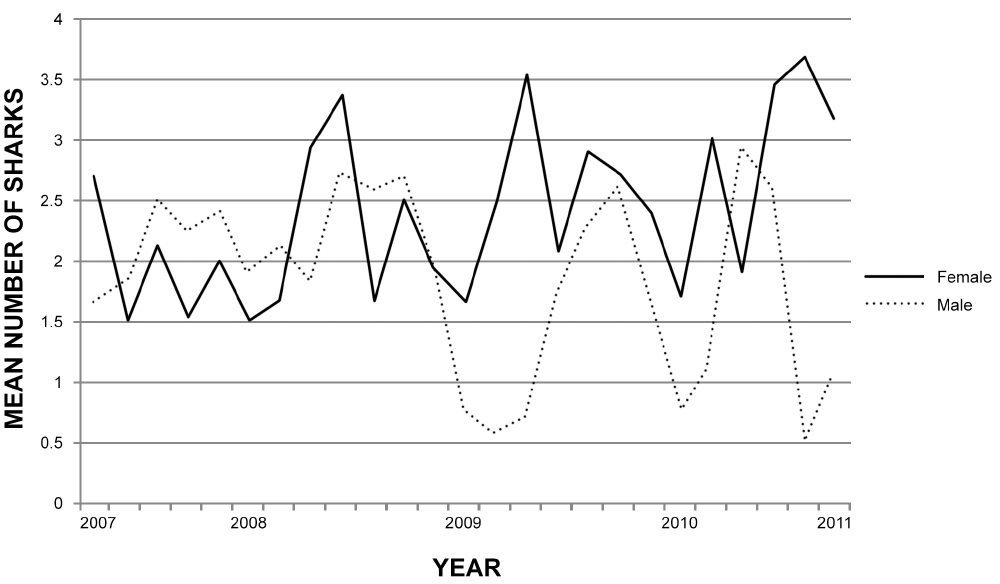
Figure 2. Interannual variability in the mean number of male and female shark sightings per trip at Dyer Island, 2007 to 2011.